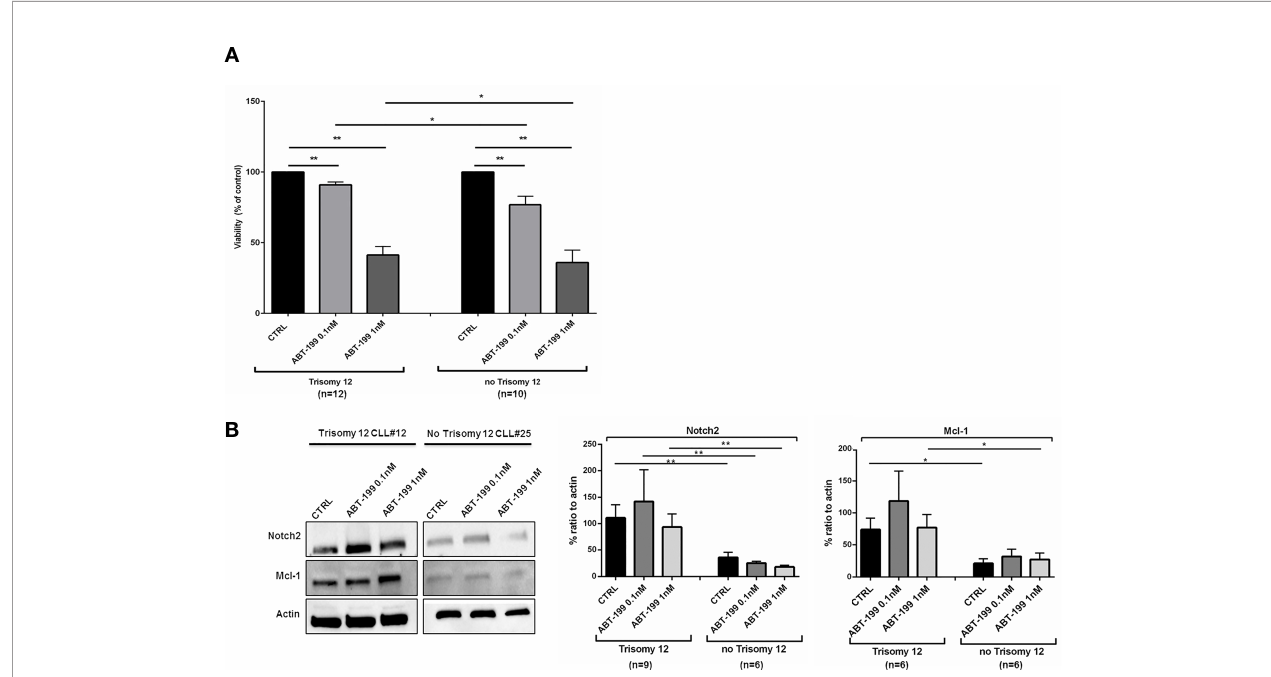
FIGURE 4 | Trisomy 12 chronic lymphocytic leukemia (CLL) cells show a reduced response to venetoclax through Notch2/Mcl-1 axis. (A) Bar diagrams show comparison on viability rate of trisomy 12 vs. no trisomy 12 CLL cells in the presence of venetoclax at two different doses of 0.1 and 1 nM treatment for 24 h (*p < 0.05, **p < 0.01). (B) Immunoblots represent the level of Notch2 and Mcl-1 in one representative trisomy 12 CLL vs. no trisomy 12 CLL patient. On the right, bar diagrams show the densitometric quanti fi cation of Notch2 and Mcl-1 in +12 and no +12 CLL cells treated with venetoclax for 24 h (*p <